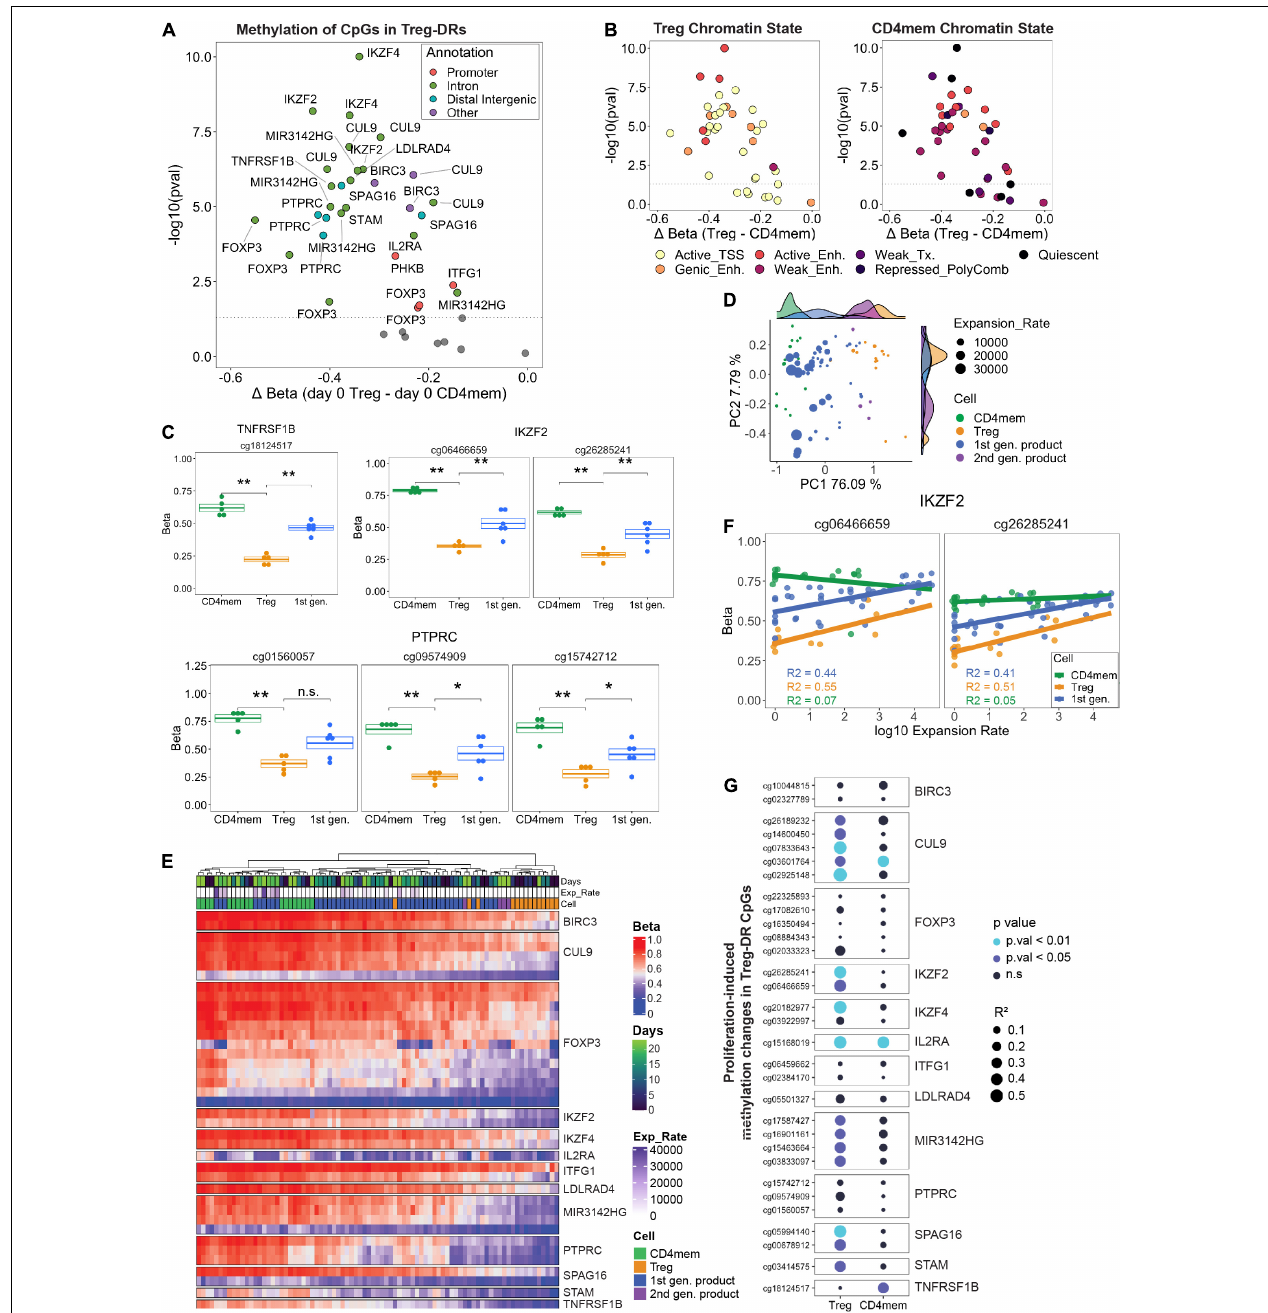
FIGURE 5 | (A) FACS-sorted Tregs and CD4 memory T cells (Day 0) were analyzed for CpG methylation at Treg specific demethylated regions (Treg-DRs). Significantly differentially methylated CpGs ( p . val < 0.05, Student’s t -test) were color-coded by genic annotation. (B) CpGs in Treg-DRs plotted with the same axes as A, but color-coded by chromatin state annotation (TSS = transcription start site; Enh. = enhancer; Tx = transcription). (C) Methylation levels (Beta) of selected Treg-DRs in Treg, CD4mem and Treg products on day 0. *denotes p .val < 0.05, ** p .val < 0.01, ns = not significant ( T test). (D) PCA analysis of day 0 and day 23 1st generation products, FACS-sorted Tregs and CD4mem as well as day 23 2nd generation products. Histograms at the top and right display representation on PC1 and PC2, respectively, of the sample distribution for each experimental group. (E) Unsupervised hierarchical clustering of all samples based on methylation levels of Treg-DRs CpGs. (F) DNA methylation change of the IKZF2 Treg-DR in CD4mem, Tregs and 1st gen Treg product in relation to the expansion rate. R 2 values display the degree of correlation (see G ). (G) Results of linear regression analysis of all differentially methylated Treg-DRs on day 0 (see A) calculating the degree of correlation between gain of methylation and log10 expansion rate. Higher R 2 value (indicated by size of the dot) indicates greater correlation. P -values are indicated by color.